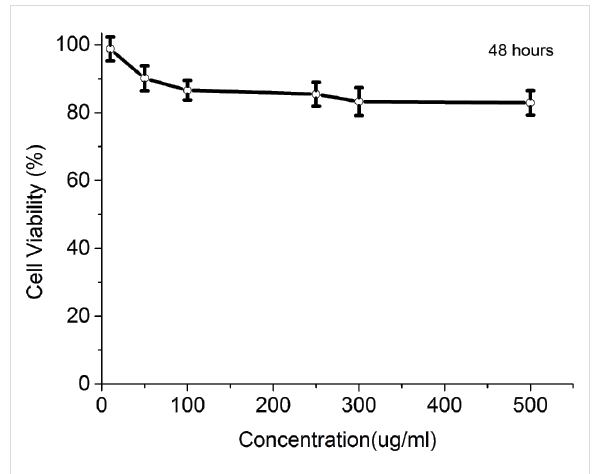
Figure 10: Viability of Panc-1 cells after 48 h of treatment in the pres- ence of F127-CdS/ZnS